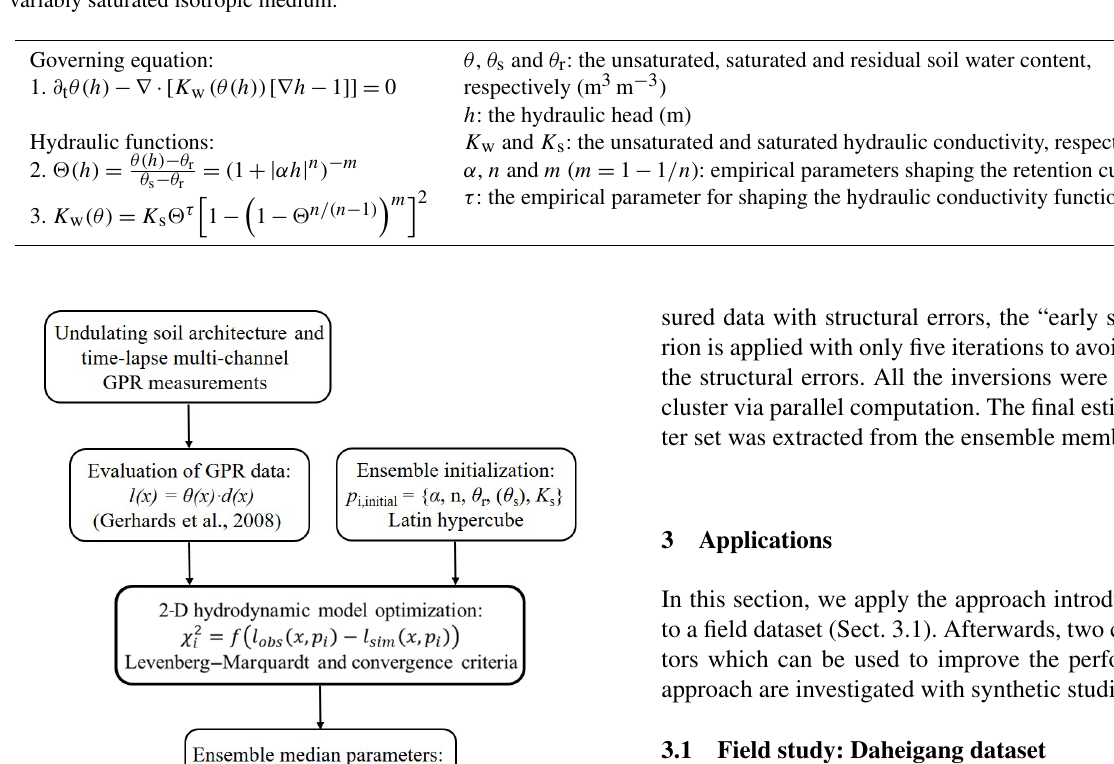
Table 1. Summary of the equations used in the muPhi model (Ippisch et al., 2006) for simulating two-dimensional Darcian water flow in a variably saturated isotropic medium.